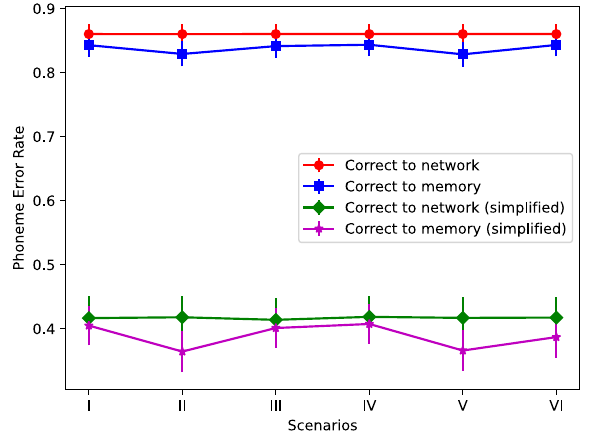
Figure 4. Phoneme Error Rate between the strings recognized by the AMRs and the string recognized by the classifier in relation to the correct string, respectively, for the six scenarios.